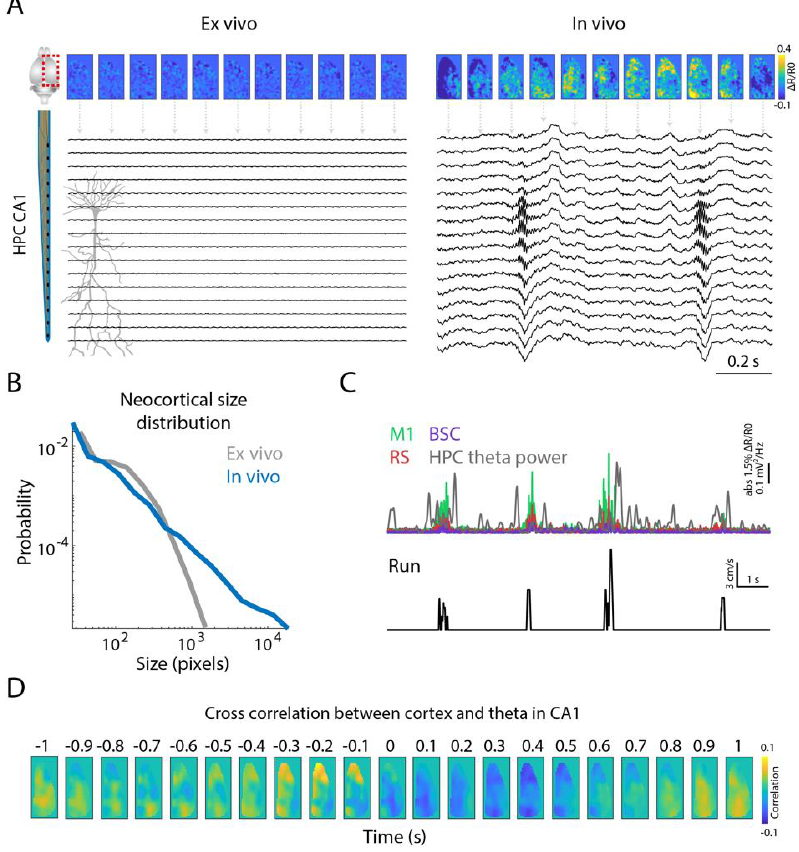
Figure 2. Signal quality. ( A ) Examples of cortical voltage imaging and hippocampal CA1 electrophysiology during ex vivo and in vivo states of an animal. ( B ) Probabilistic distribution of neocortical transients based on the spatial extent of the activity fluctuations (size) for ex vivo and in vivo states. As expected, the transients in the in vivo state obey a distribution that is more likely to follow a power-law scale. Smaller transients, also present in the ex vivo preparation, are likely due to noise. ( C ) Simultaneously recorded absolute ∆ R/R cortical activity and hippocampal theta power during active (run periods) and quiet behaviors. Note that during the running periods the animal presented a higher modulation of the cortical voltage signal, which is similar to the increased theta power in the hippocampus. The labels are defined as primary motor cortex (M1), retrosplenial cortex (RS), barrel cortex (BSC) and hippocampal (HPC) theta power. ( D ) Cross correlation between the cortical pixels and theta power in the hippocampal stratum pyramidale.